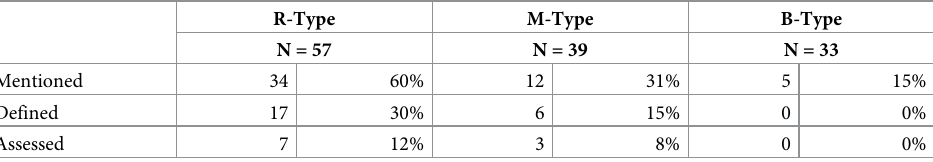
Table 5. RPT documents’ relevant references to collegiality and related terms by institution type. R-Type M-Type B-Type Mentioned Defined Assessed N.B. The conditions of the chi-square test were not met for the codes Defined or Assessed, but the chi-square analysis reveals the difference in the Mention of the concept of collegiality between institution types are significant. Chi-